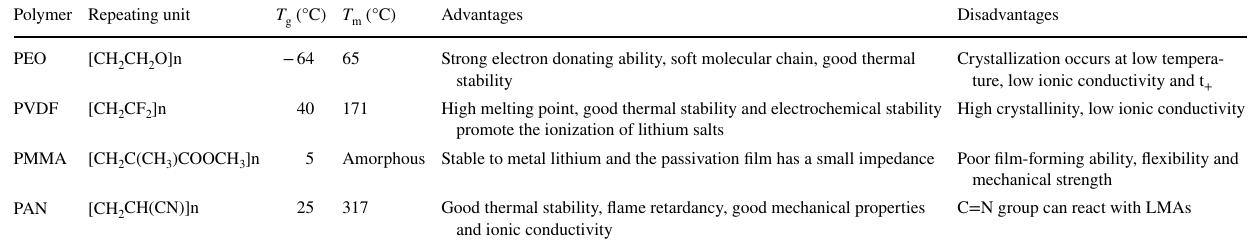
Table 1 Main properties of polymer matrix [76–79] Polymer Repeating unit